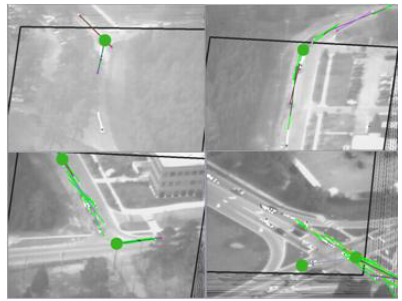
Figure ７ : Road Intersection Identification